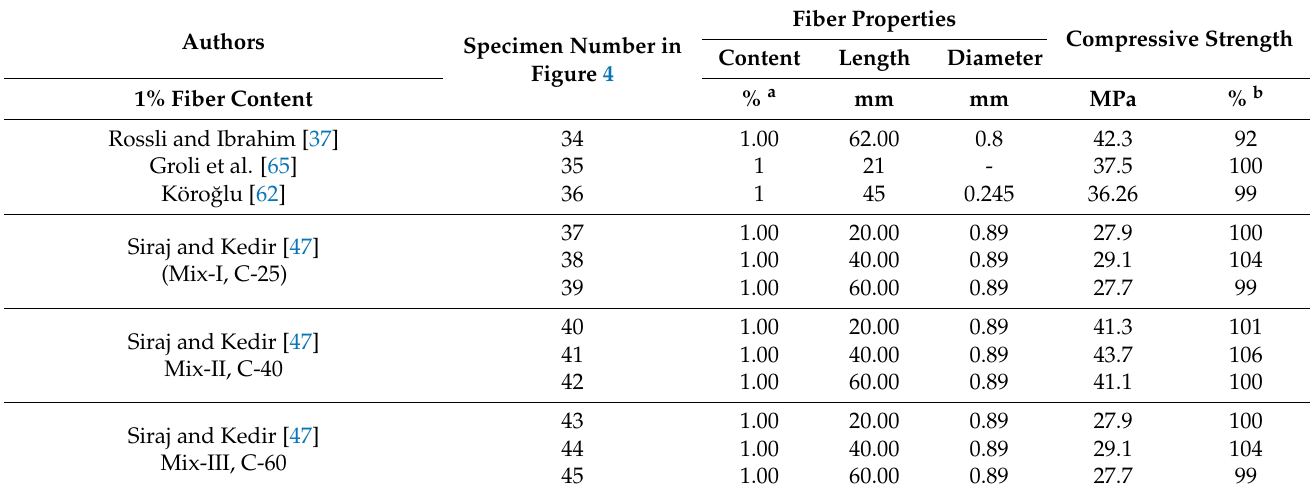
Table 3. Results of compressive strength’s percent comparison and fiber properties of the concrete having 1% or greater than 1% RSF by its volume